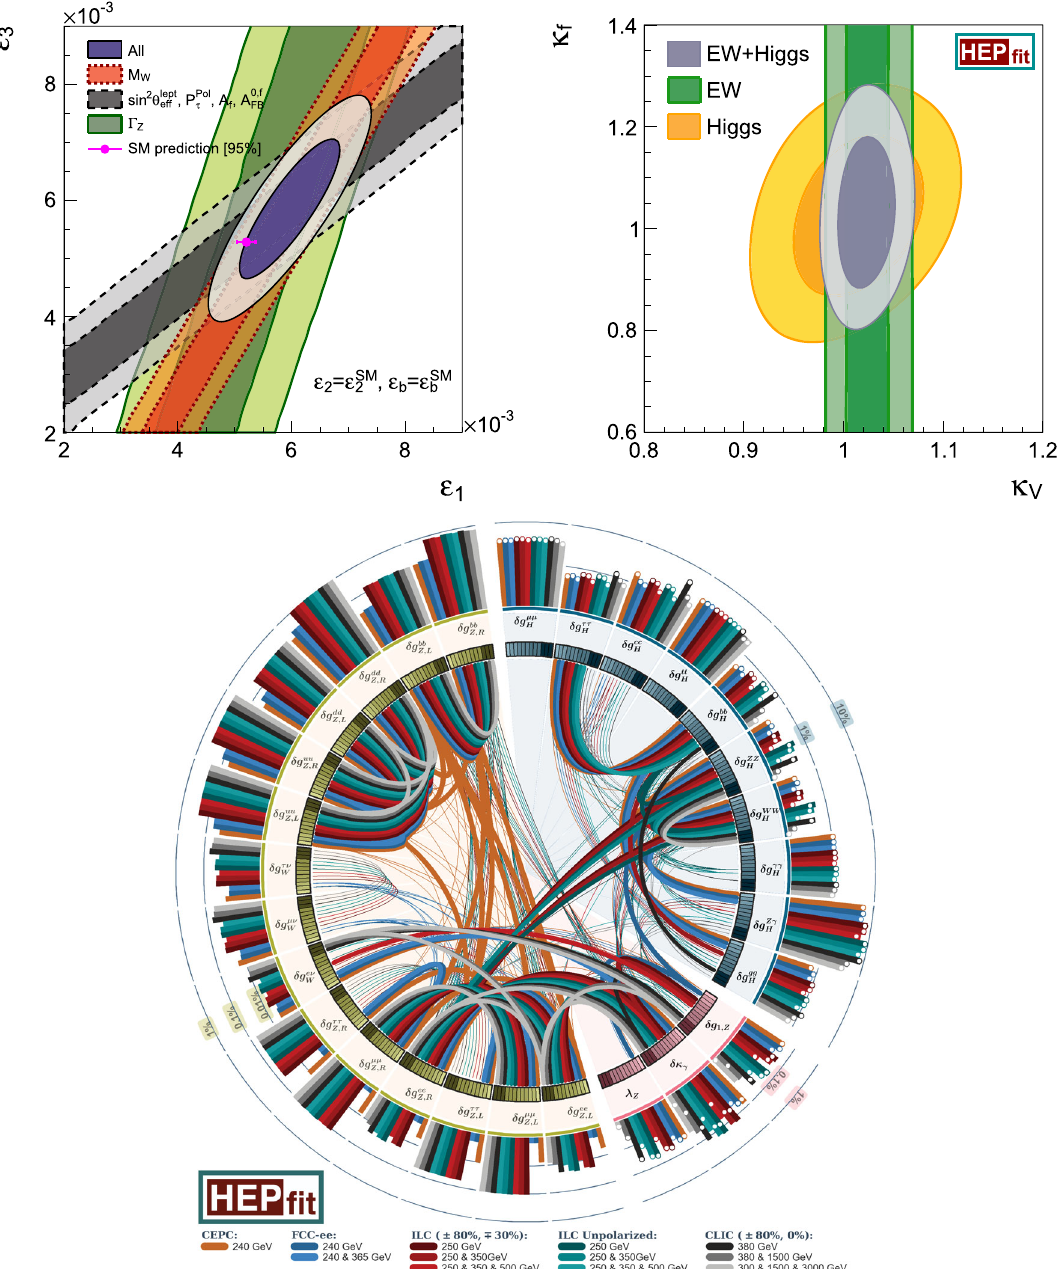
Fig. 1 Selected results from the papers presented in Sect. 5.1. Top left obtainedfromthefittotheHiggs-bosonsignalstrengthsandtheEWPO. (from Ref. [4]): two-dimensional probability distribution for ε 1 and ε 3 Bottom (from Ref. [28]): a scheme-ball illustration of the correlations between Higgs and EW sector couplings. The Z -pole runs are included in the fit, assuming ε 2 = ε SM and ε b = ε SM , showing the impact of dif- b 2 for FCC-ee and CEPC. Projections from HL-LHC and measurements ferent constraints. The SM prediction at 95% is denoted by a point with from LEP and SLD are included in all scenarios. The outer bars give an error bar. Top right (from Ref. [7]): two-dimensional 68% (dark) and the 1 σ precision on the individual 95% (light) probability contours for κ V and κ f (from darker to lighter),